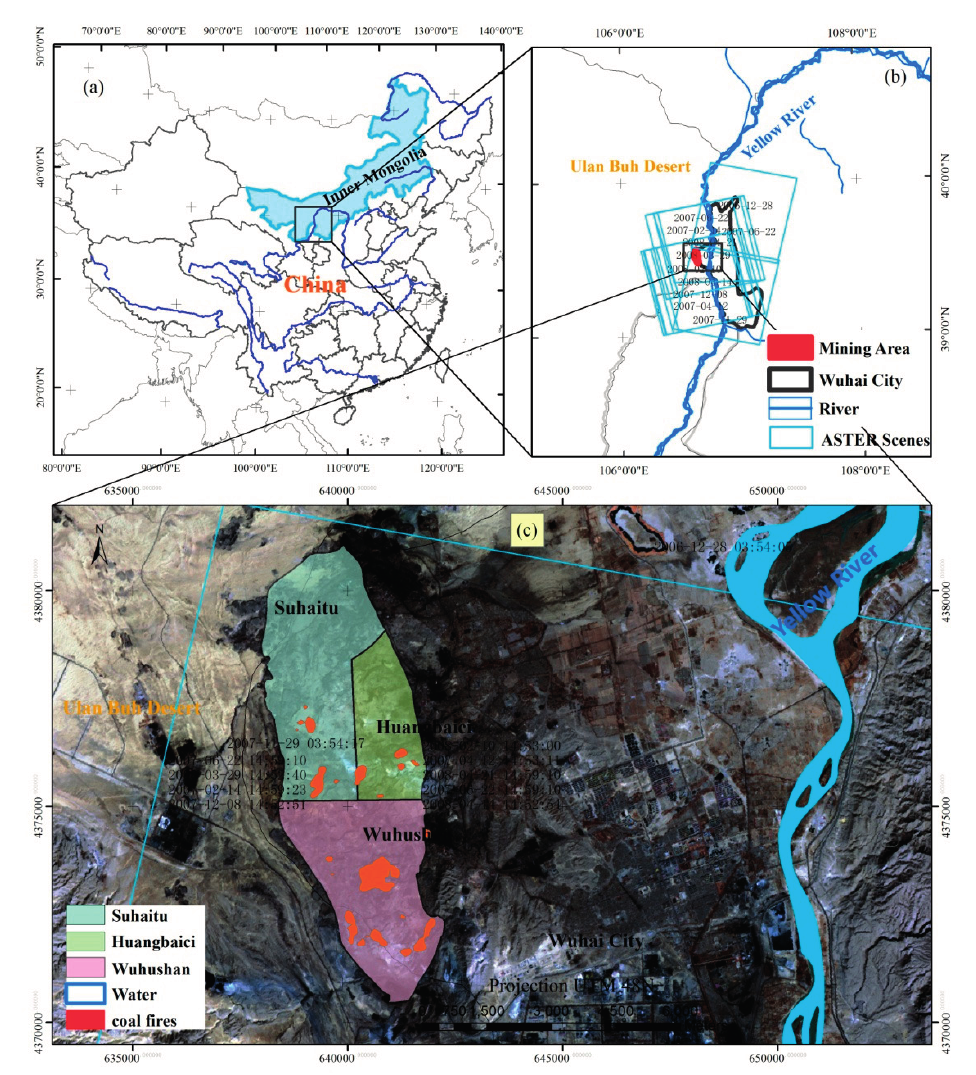
Figure 1. Study area location and the distribution of the ASTER scenes. ( a ) Location of the study area in China; ( b ) study area in Inner Mongolia. The blue parallelograms indicate the boundary of ASTER scenes; ( c ) the Wuda coal field, an ear-shaped syncline, includes three coalmines in the study area and is overlaid with the ASTER false color composite image. The coal fire polygons (in red) depict the thermal anomalies for 29 November 2007, 03:54 A.M.